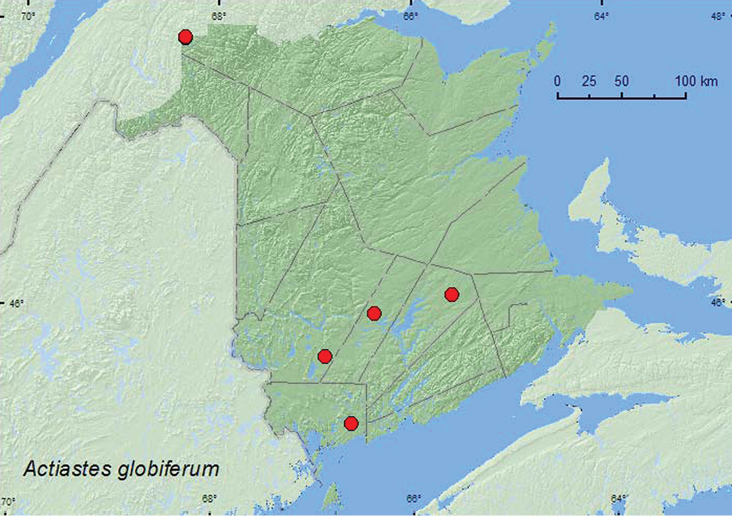
Collection localities in New Brunswick, Canada of Actiastes globiferum.